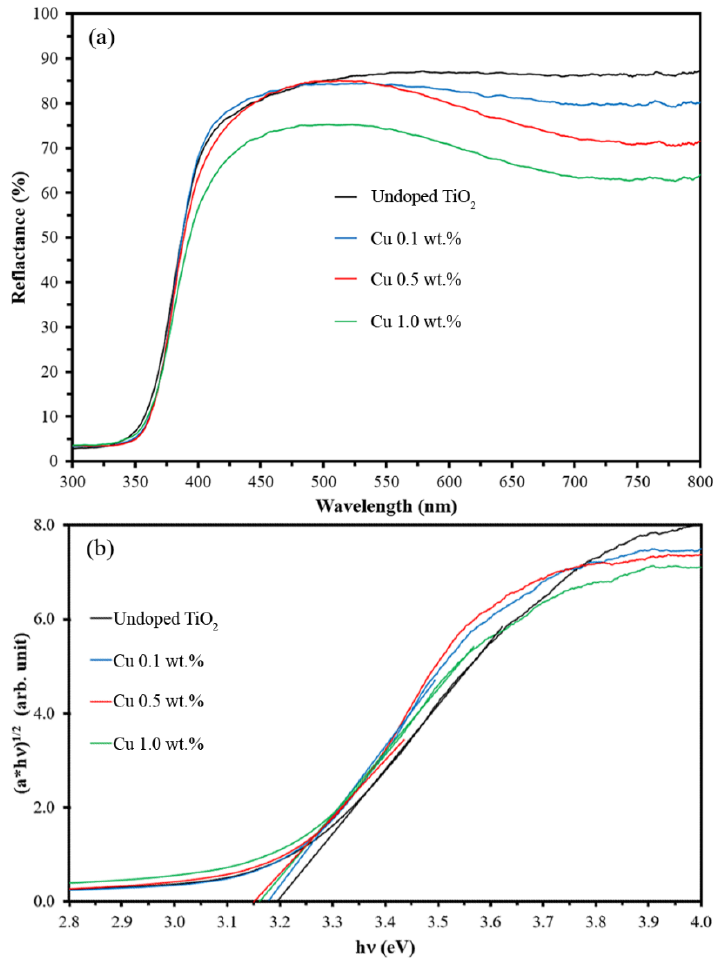
Figure 4. Reflection spectra ( a ) and Tauc plot ( b ) of Cu-doped TiO 2 nanoparticles. According to the Tauc plot [33], the result revealed that the band gap was reduced by increasing Cu doping levels, as shown in Figure 4. This is because the Cu 2+ ions generated sub-bands near conduction band, resulting in the band gap reduction of Cu-doped TiO 2 . Concurrently, the sub-bands also increased the electron-hole recombination time. These two phenomena increased the performance of photocatalytic efficiency, as shown in the MB degradation test presented in Figure 5.